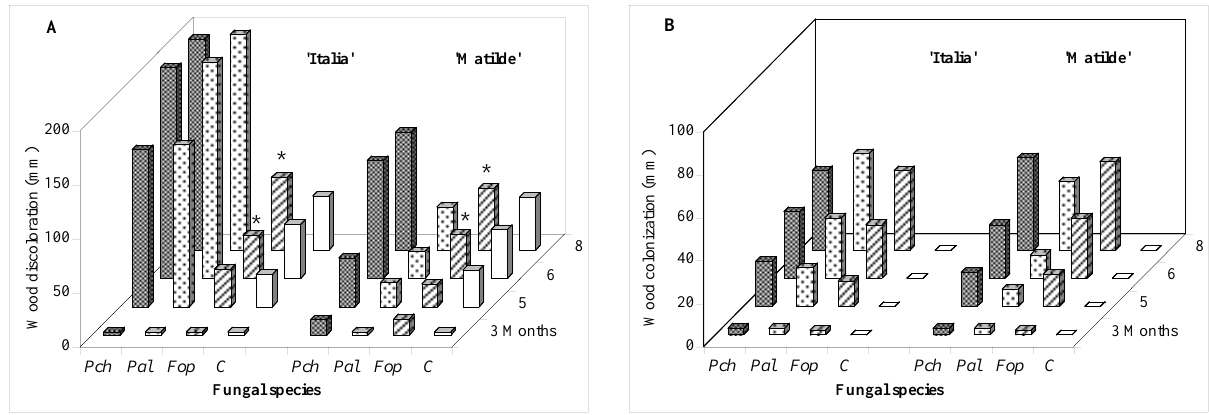
Fig. 1. A. Length of wood discoloration in trunks of 6-year-old grapevines cv. Italia or branches of 9-year-old grape- vines cv. Matilde, 3 to 8 months after inoculation with Phaeoacremonium chlamydosporum ( Pch ), P. aleophilum ( Pal ) and Fomitiporia punctata ( Fop ); control ( C (cid:1) ). Data are the means of 5 replicates. An asterisk (*) indicates the appearance of the first signs of spongy wood decay (white rot). B. Corresponding extent of wood coloni- sation by the above fungi, based on successful re-isolation of the